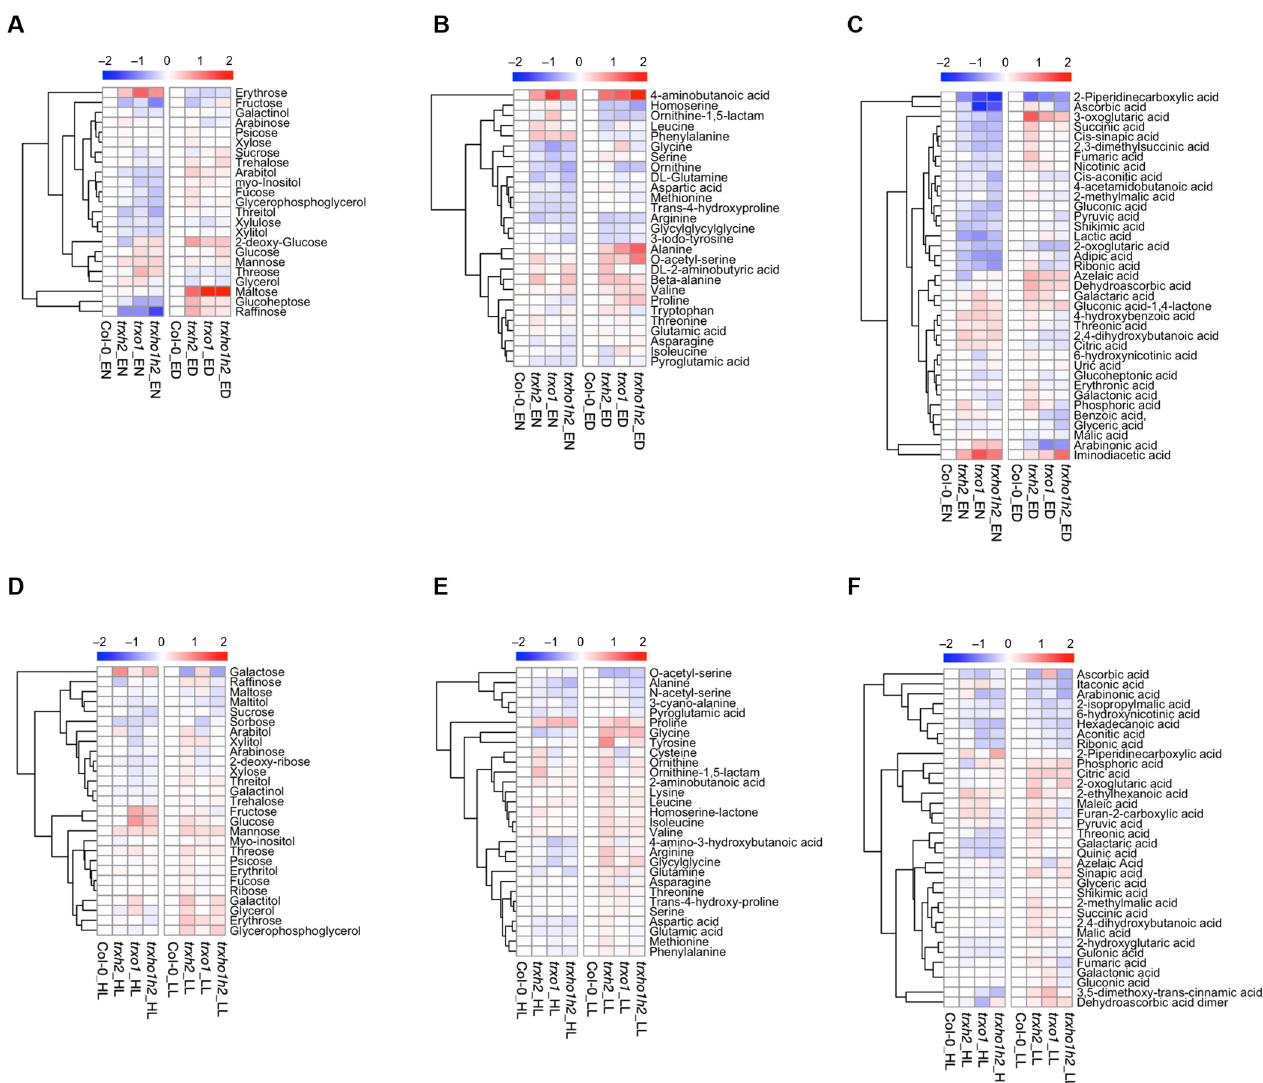
Figure 5. Metabolite profile of the wild type (Col-0) and the mutant lines ( trxh2 , trxo1 and trxo1h2 ). Arabidopsis plants grown under medium light conditions ( A – C ) were harvested at the end of the night (EN) and the end of the day (ED), respectively. Arabidopsis grown under fluctuating light conditions ( D – F ) were harvested at the high-light phase (HL) and low-light phase (LL), respectively. The samples were used for metabolite profiling via GC-TOF-MS. ( A , D ), Sugars and sugar alcohols. ( B , E ), Amino acids. ( C , F ), Organic acids and TCA cycle intermediates. Results are normalized to Col-0 with log 2 transformation and visualized as a heatmap with hierarchical clustering done by R software. Data are taken from Tables S1 and S2.